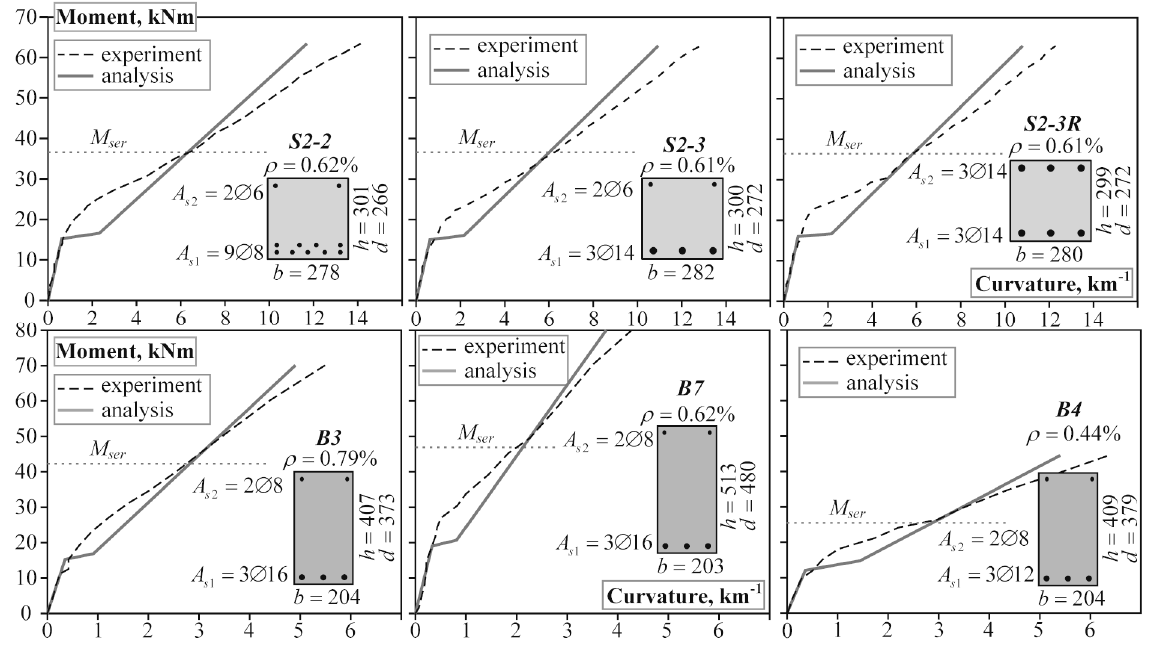
Fig. 6. Moment-curvature diagrams obtained by Kaklauskas et al. (2008) (top) and by Clark and Speirs (1978) (bottom)